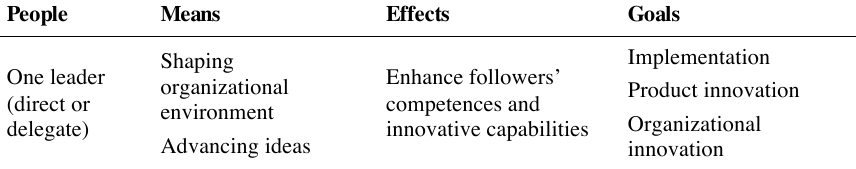
Enhance followers’ competences and innovative capabilities